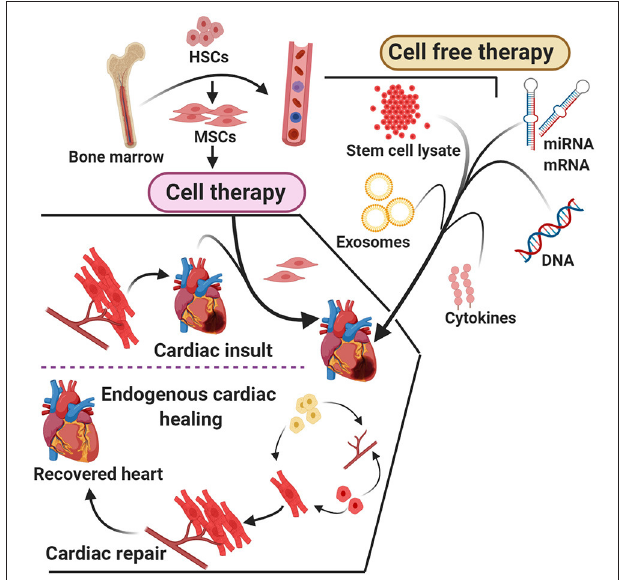
FIGURE 3 | A head-to-head comparison of cell therapy and cell-free therapy.